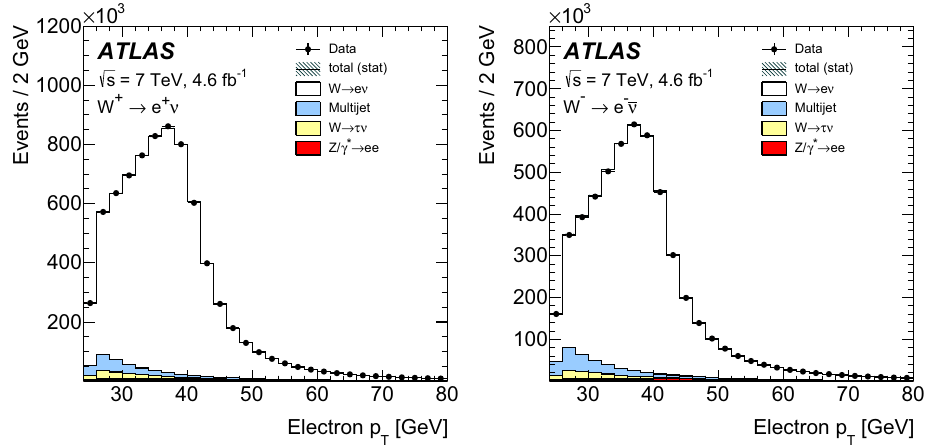
Fig. 3 The transverse momentum distribution of electrons for W + → e + ν candidates( left )and W − → e − ¯ ν candidates( right ).Thesimulated samples are normalized to the data luminosity. The multijet background shape is taken from a data control sample and normalized to the esti-